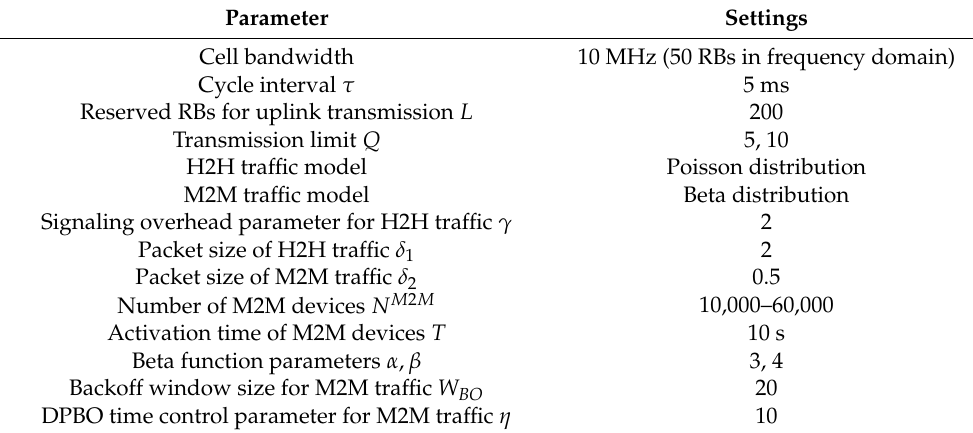
Table 1. Performance Evaluation Parameters for Proposed HSTMAC Protocol.